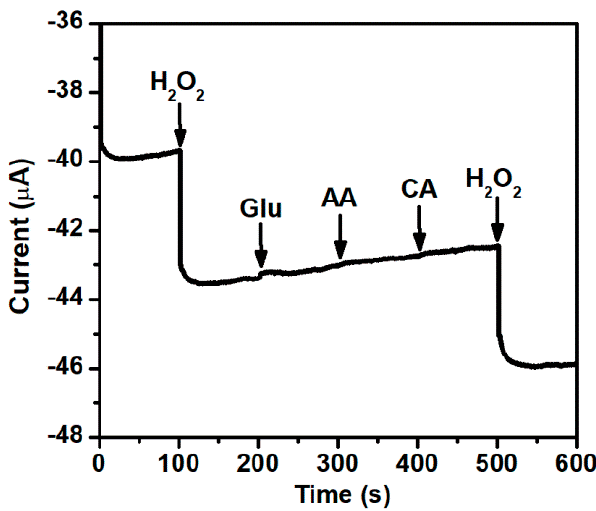
Figure 8. Amperometric response of the Ag-AuNPs/RGO modified GCE for the successive addition of H 2 O 2 , glucose, AA and CA (1 mM, respectively) in Ar-saturated 0.1 M PBS (pH 7.2) at − 0.2 V.